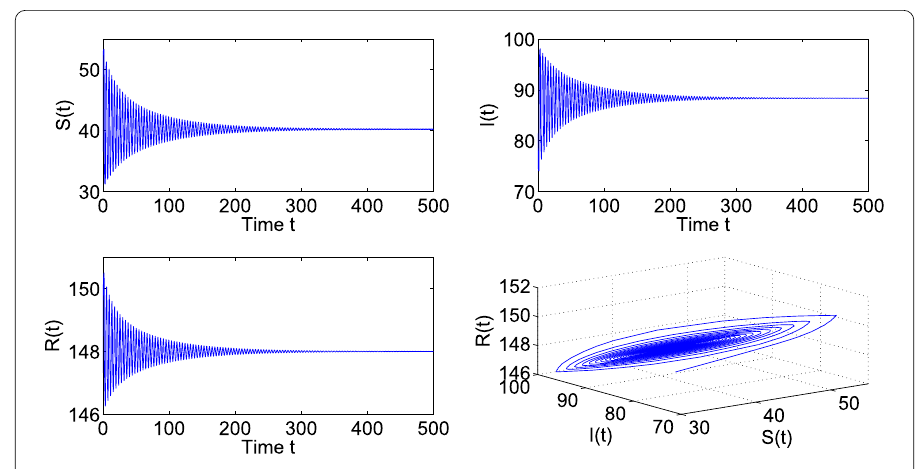
Figure 2 E ∗ is locally asymptotically stable when τ 1 = 1.850 < τ 10 =